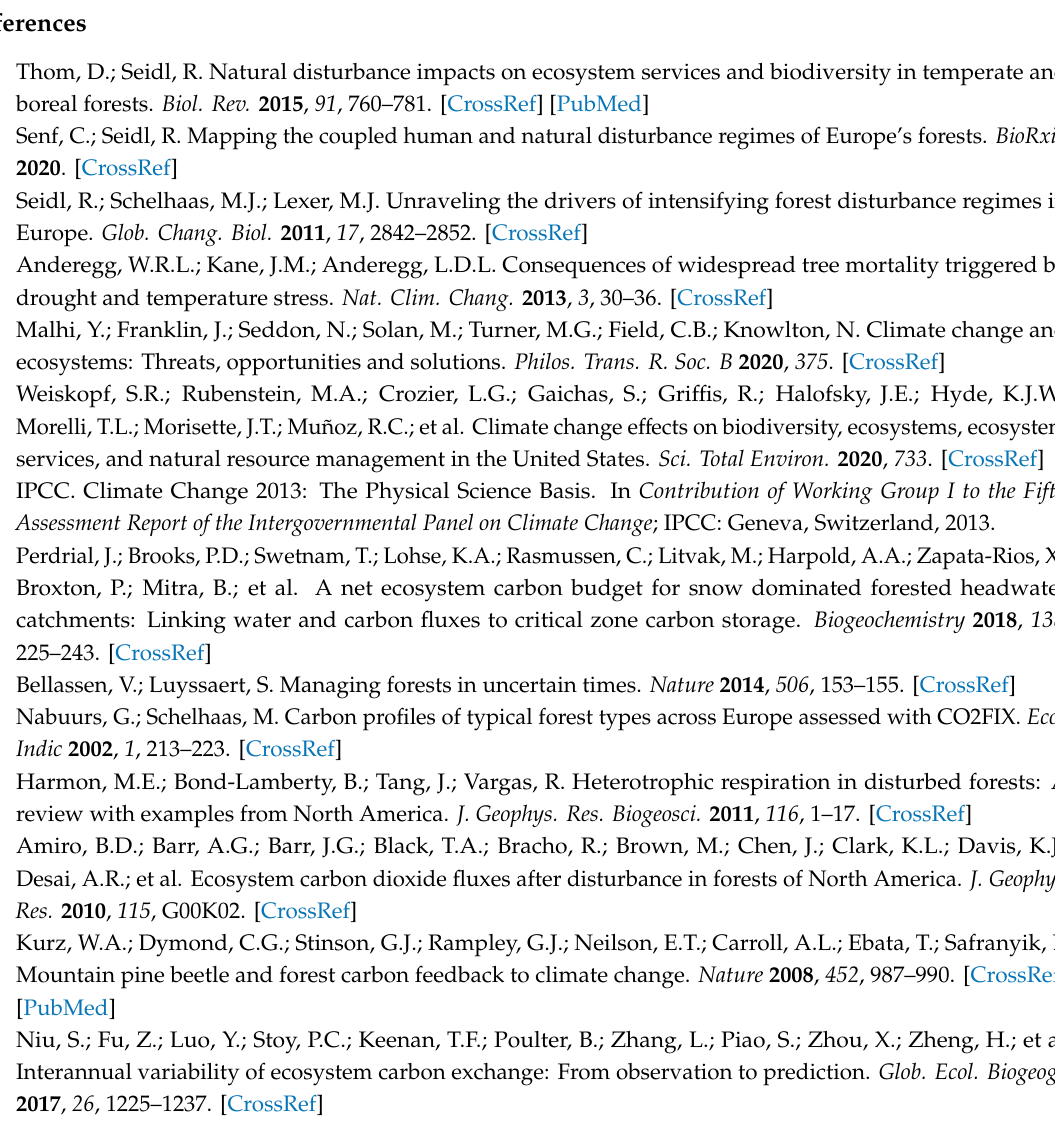
Figure S1: The entire study catchments (black line) and carbon study parts (MP—Mlynick ý potok Creek catchment red cross-hatched, VP—Velick ý potok Creek catchment blue cross-hatched, SP—Slavkovsk ý potok Creek catchment green cross-hatched), Figure S2: Light response curves for selected (a) grass, herb and shrub species; (b) tree species. Table S1: Average 2-week GPP max [ µ mol C m − 2 s − 1 ] and α parameters estimated from light response curves for the key species in studied